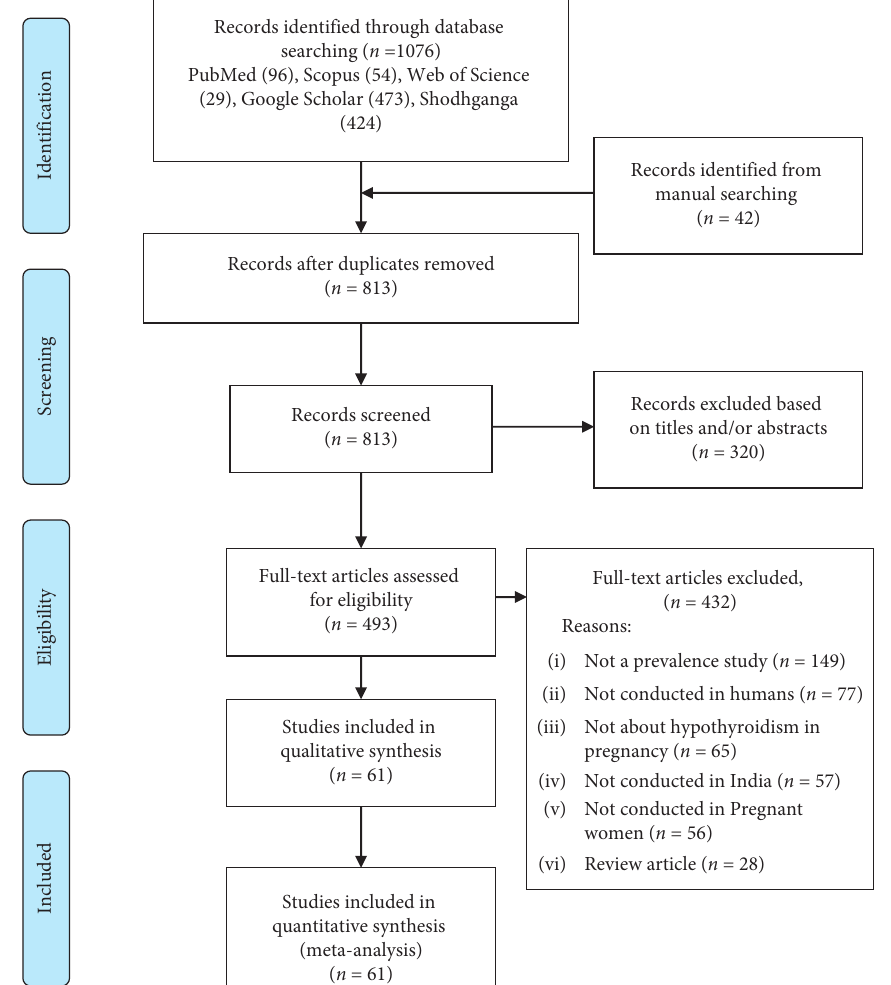
Figure 1: Prisma